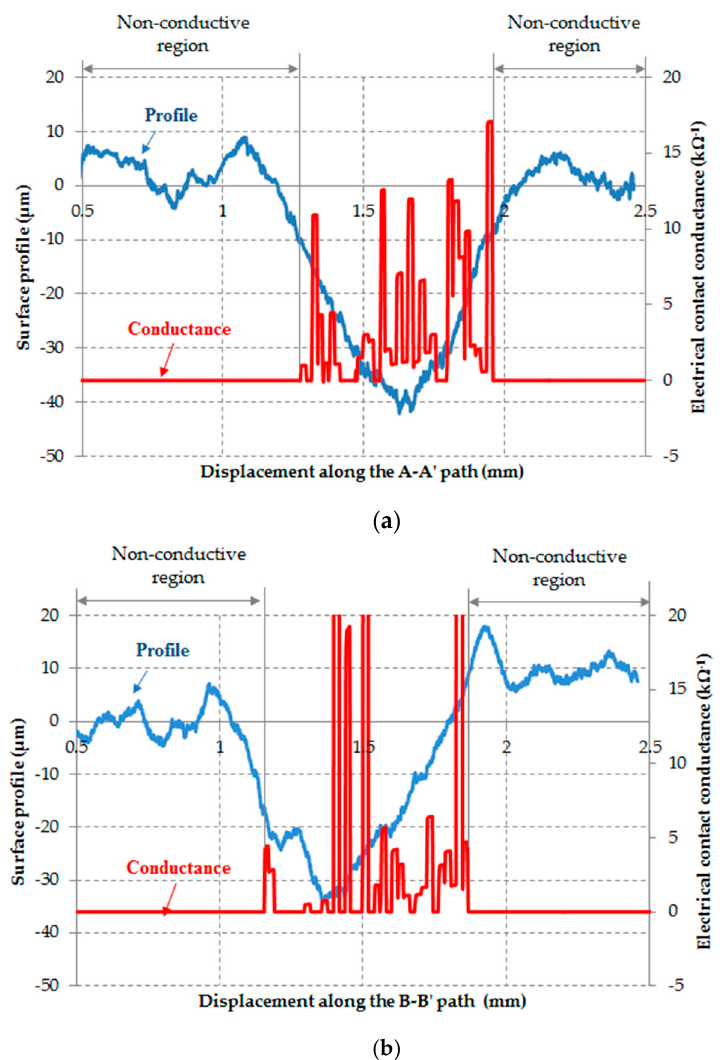
Figure 4. Surface profile and electrical contact conductance: ( a ) A–A’ direction; ( b ) B–B’